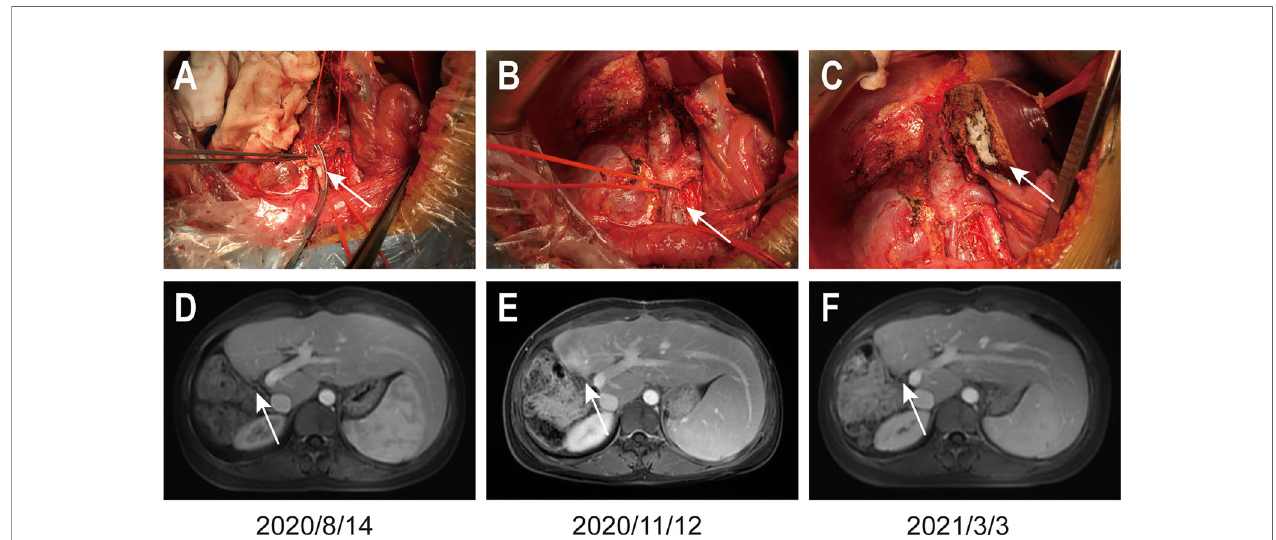
FIGURE 4 | Images of the operation and the MRI reexamination after surgery. (A) shows the inferior vena cava embolectomy, (B) shows the sutured inferior vena cava, and (C) shows the liver incisal margin. Arrows in (A, B) fi gures indicate the position described above. (D – F) show the MRI reexamination after surgery. Arrows in (D – F) fi gures indicate the liver resection